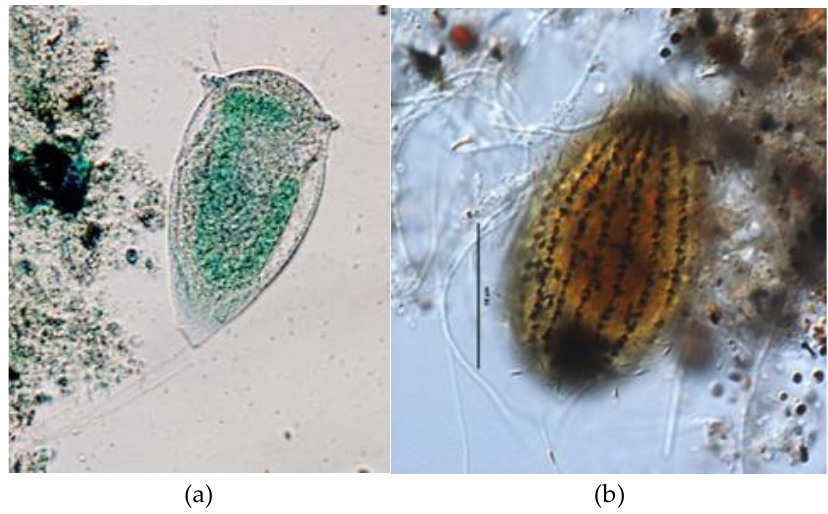
Figure 3. ( a ) Vorticella octava in transmitted light; ( b ) Vorticella convallaria —phase contrast.